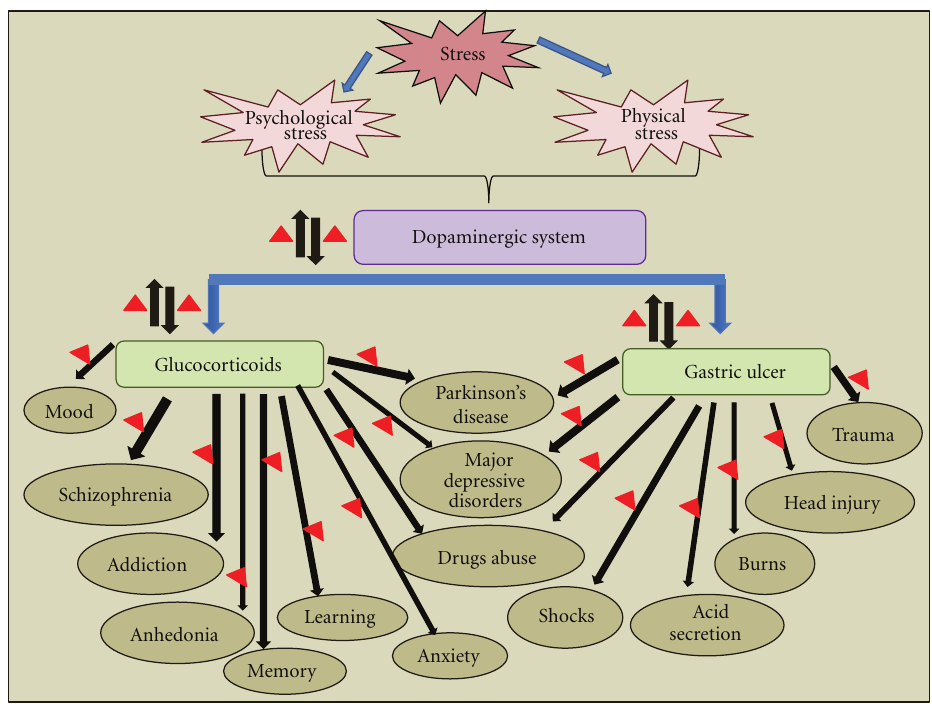
Figure 1: Overview of stress-induced dopaminergic modulations and their associated changes in glucocorticoid and gastric ulcer. Stressful stimuli lead to dopamine release in the brains of animals or humans. The number of neurological disorders has been linked to the dopaminergic modulated response due to physiological or psychological stressors via perturbations in glucocorticoids and gastric ulcer. Up and down arrows together indicate modulations, and triangles indicate possible therapeutic